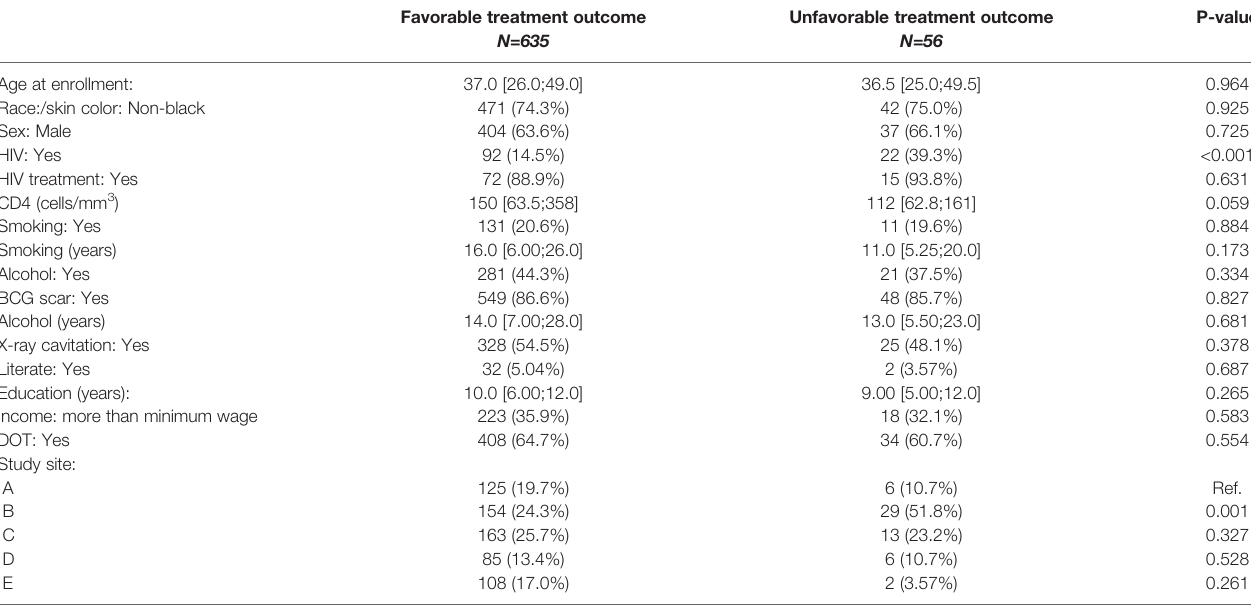
TABLE 3 | Sociodemographic characteristics, strati fi ed by TB treatment outcome.